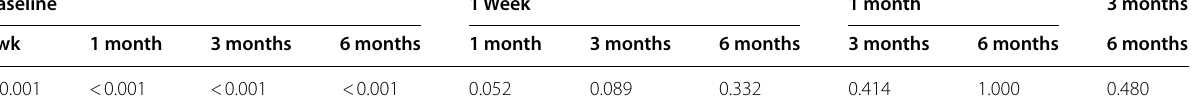
P -value > 0.05: Non-significant; P -value < 0.05: Significant; P -value < 0.01: Highly significant ≠